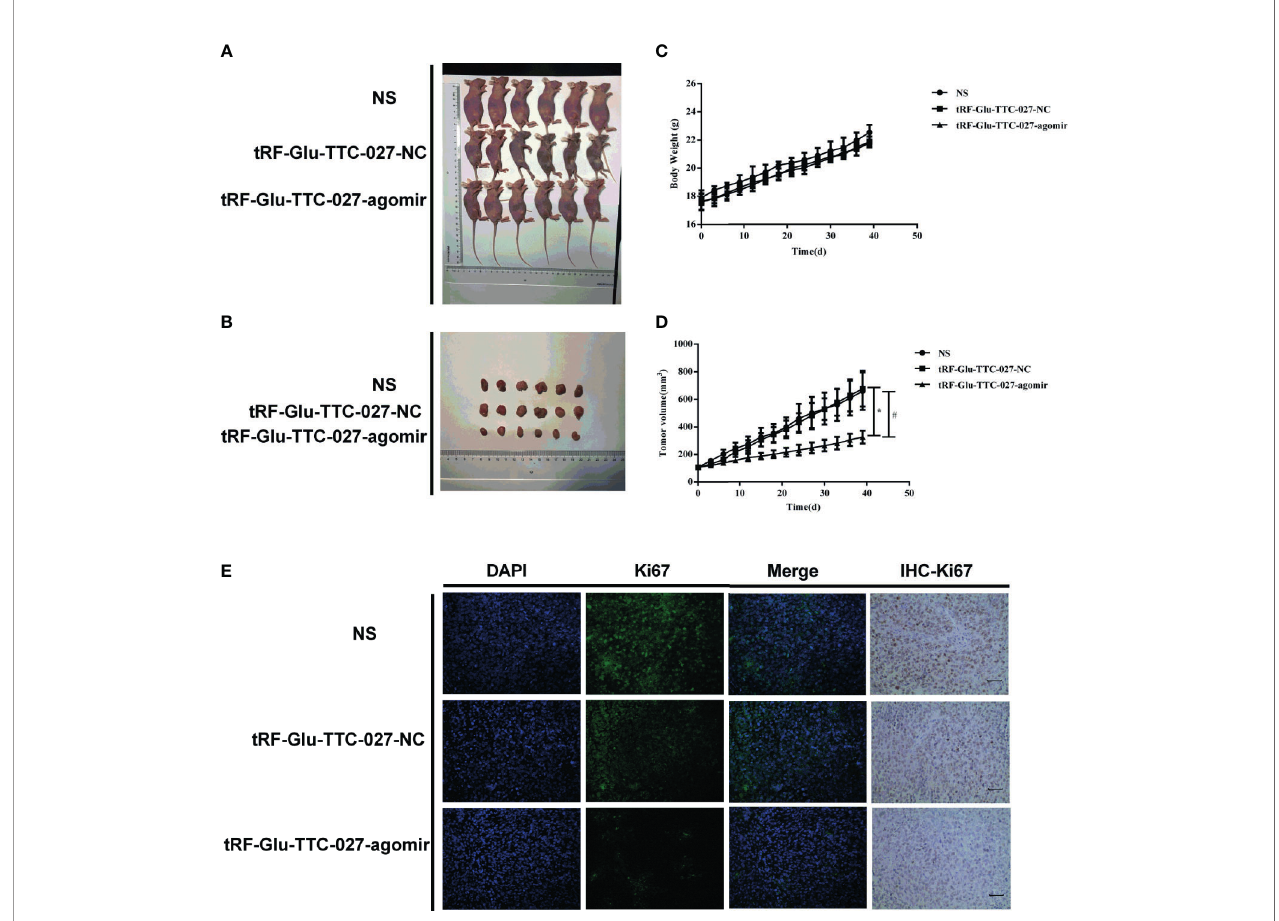
FIGURE 8 | tRF-Glu-TTC-027 decreased tumor growth in NCI-N87 xenografts. (A, B) Representative images of NCI-N87 xenografts in vivo . Six mice are included in each group. (C, D) The data of body weight and tumor volume in each indicated group. tRF-Glu-TTC-027 signi fi cantly suppressed tumor growth. And there was no signi fi cant difference among these three groups in terms of the bodyweight of the mice. (E) We then conducted the immuno fl uorescence assay and IHC assay for Ki67 to further con fi rm the proliferative activity of xenografts. The fl uorescence density of Ki67 decreased signi fi cantly in the tRF-Glu-TTC-027 agomir group compared with NS and tRF-Glu-TTC-027 NC group, and the result was consistent with the IHC assay. (* # P < 0.05, Student ’ s t-test. Scale bar = 100